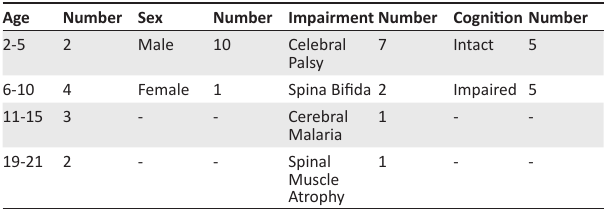
TABLE 1a: Demographics of the children with disabilities.